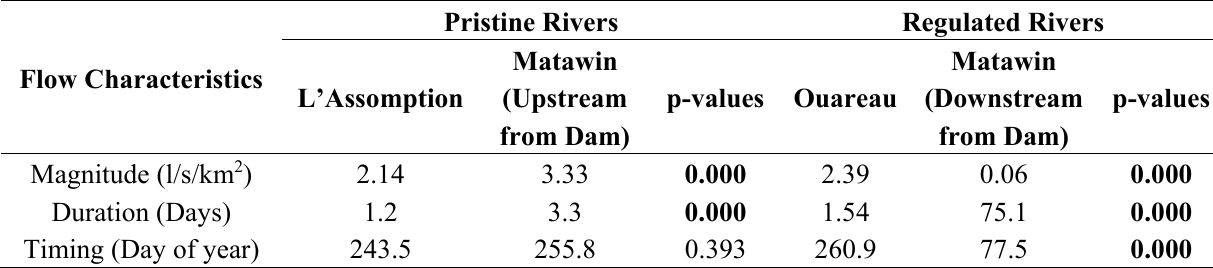
Table 2. Comparison of mean values of daily annual minimum flow characteristics using the paired t test (1930–2010).